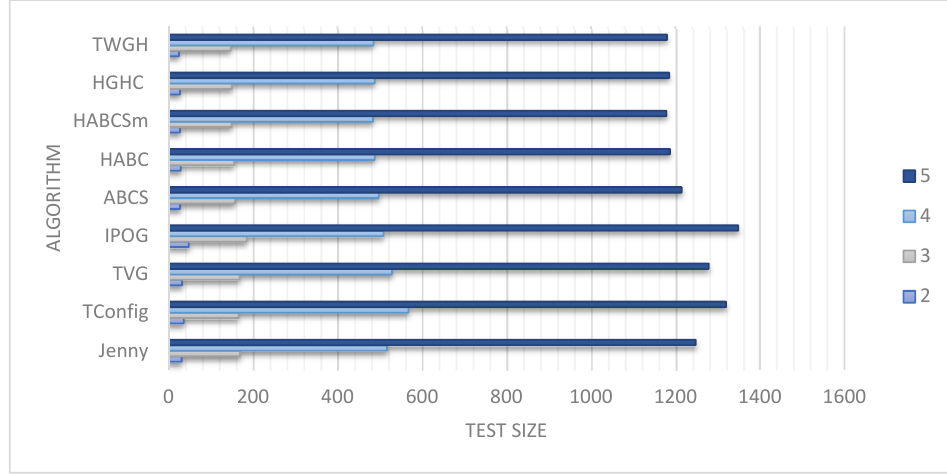
Figure 4. Test set size for CA (N; t, v 7 ) with t=4 and 2 ≤ v ≤ 5.